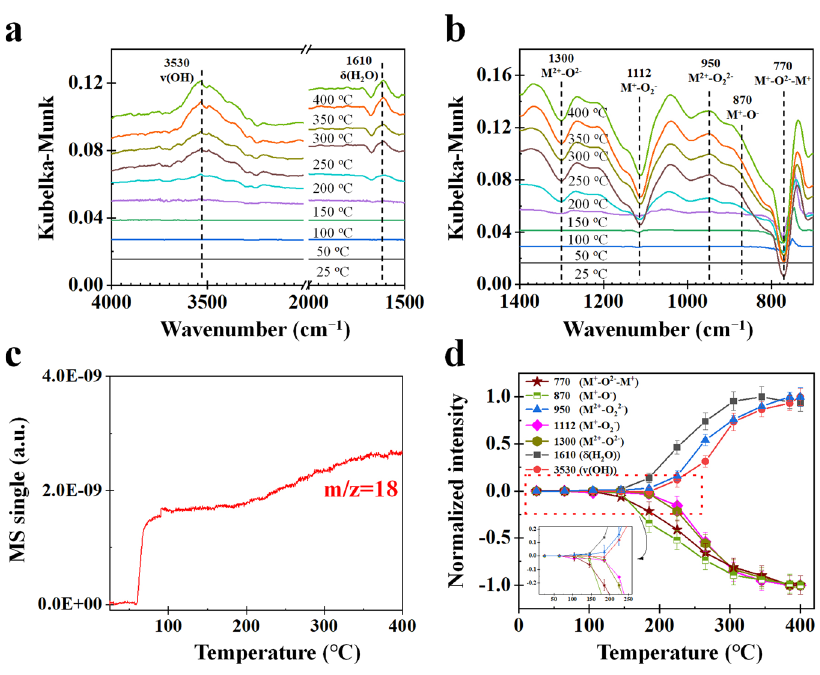
Fig. 3 Experimental results of H 2 oxidation by oxygen species at β -MnO 2 surfaces in (H 2 + O 2 ) as a function of temperature. a , b DRIFTS spectra. c MS signal. d Normalized intensities where the error bars are the standard deviations obtained by measuring the peak heights more than three times.